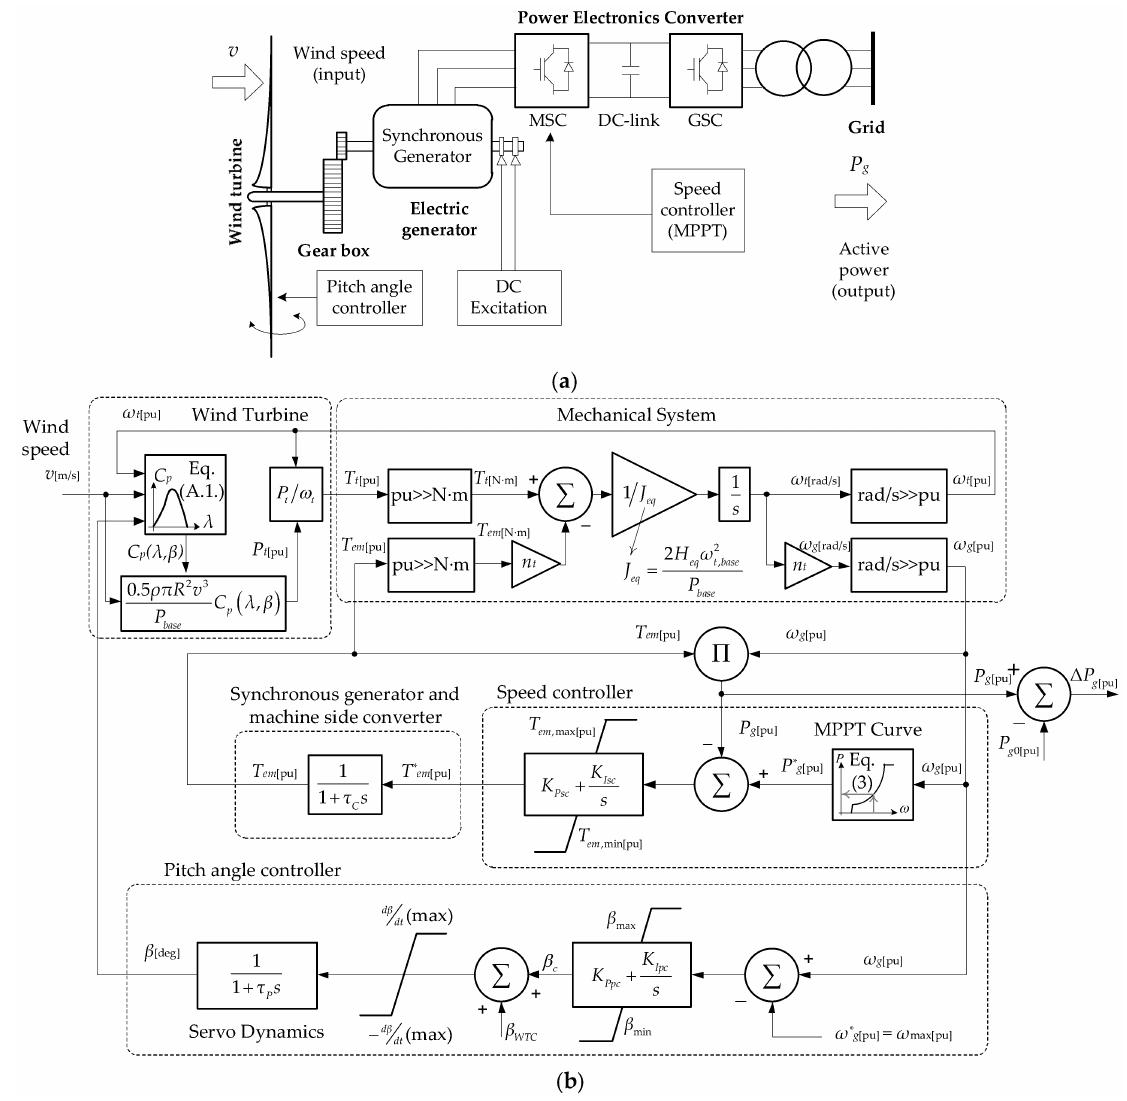
Figure 3. Wind turbine installed at the San Cristobal wind farm: ( a ) General layout; ( b ) Simplified electro-mechanical